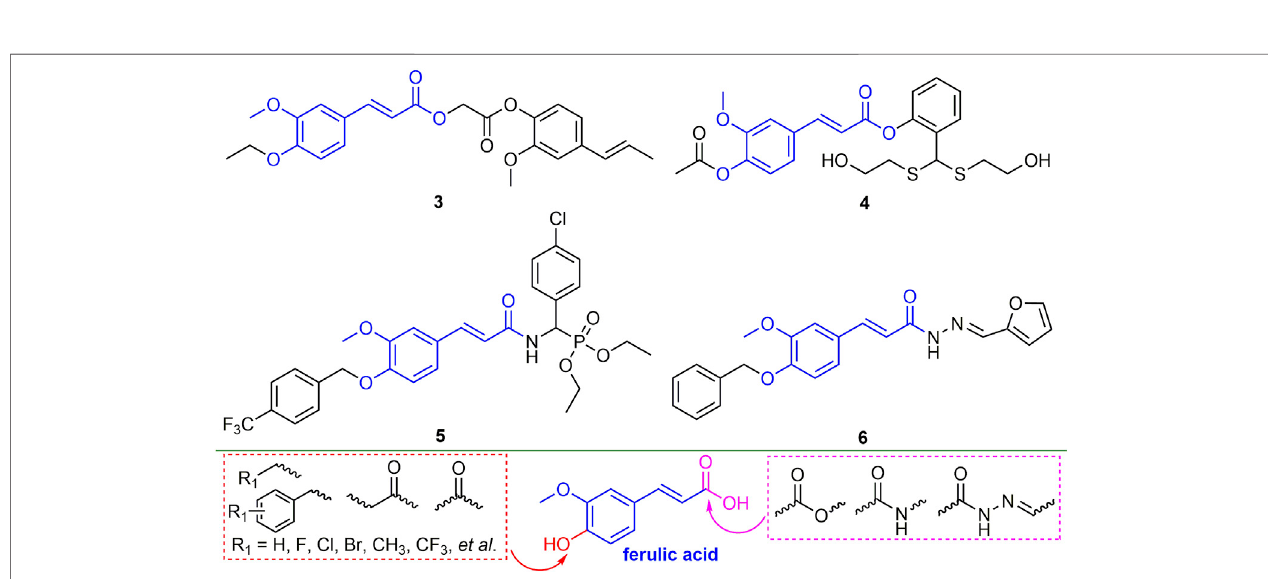
FIGURE 3 | Structures of representative ferulic acid derivatives in antiviral